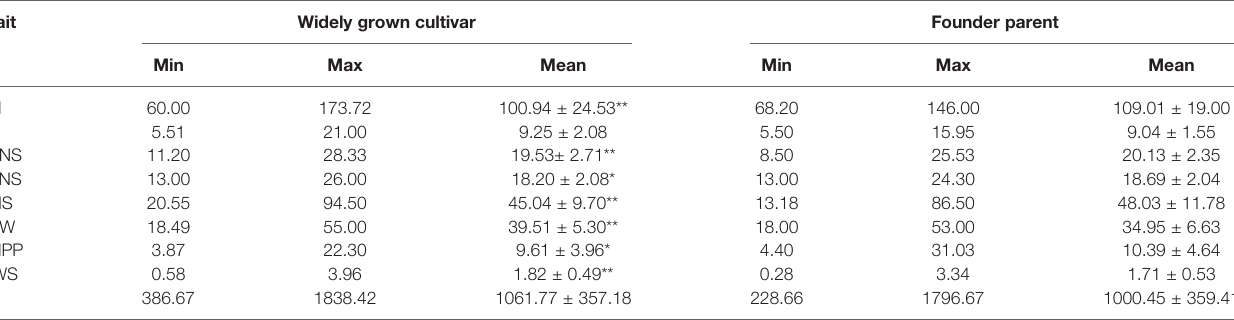
TABLE 2 | The phenotypic variation in eight traits and yield between founder parents and widely grown cultivars. Trait Widely grown